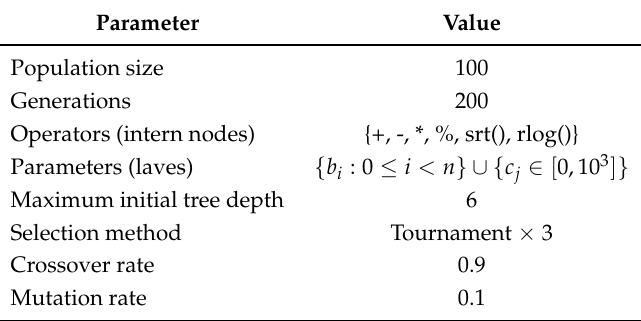
Table 2. Genetic Programming (GP) parameters setup. The three last operators mentioned stands